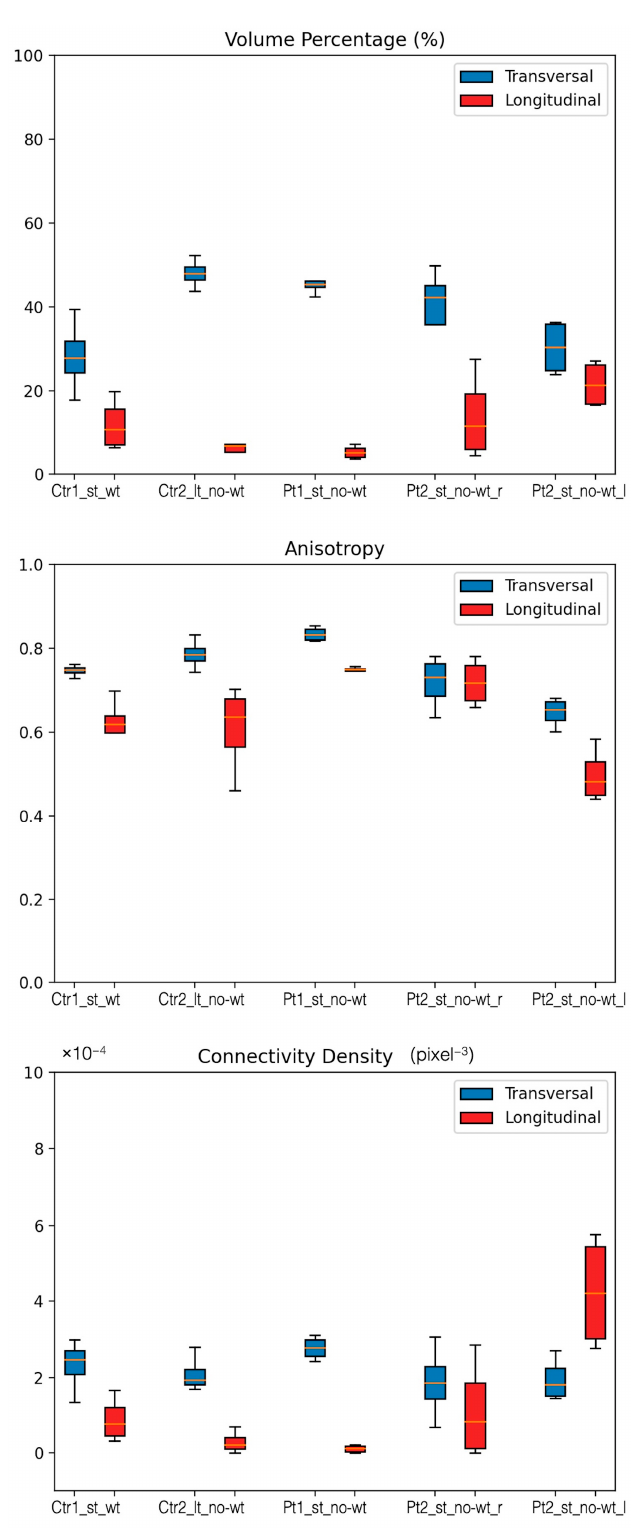
Figure 6. Box plots of volume percentage, degree of anisotropy and connectivity density calculated on each volume segmented with deep learning: transversal fibers (blue), longitudinal fibers (red). In terms of volume percentage, the quantity of transverse bundles was always shown to be higher than for longitudinal